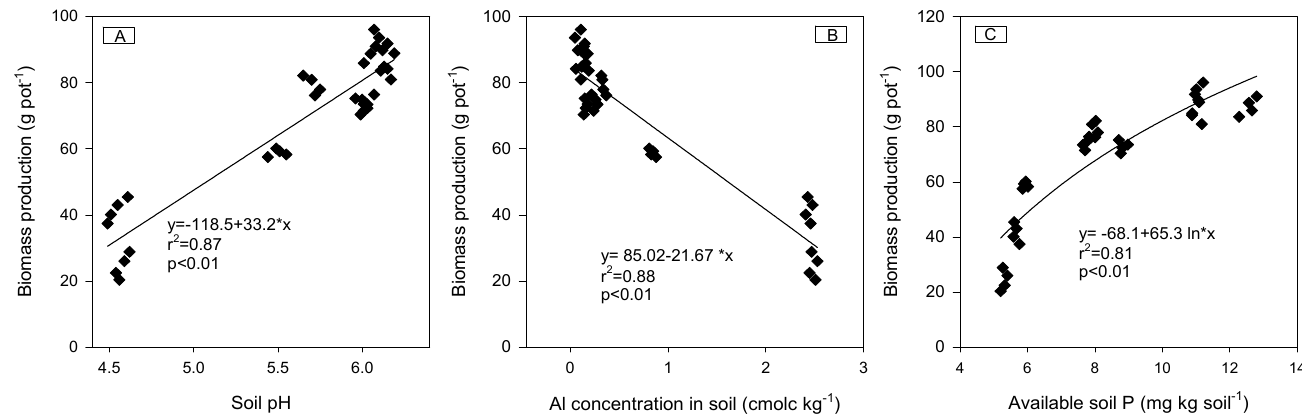
Figure 4. Relationship between soil pH and biomass production ( A ), exchangeable Al concentration in soil and biomass production ( B ), and available soil P and biomass production ( C ). The asterisk stands for multiplication